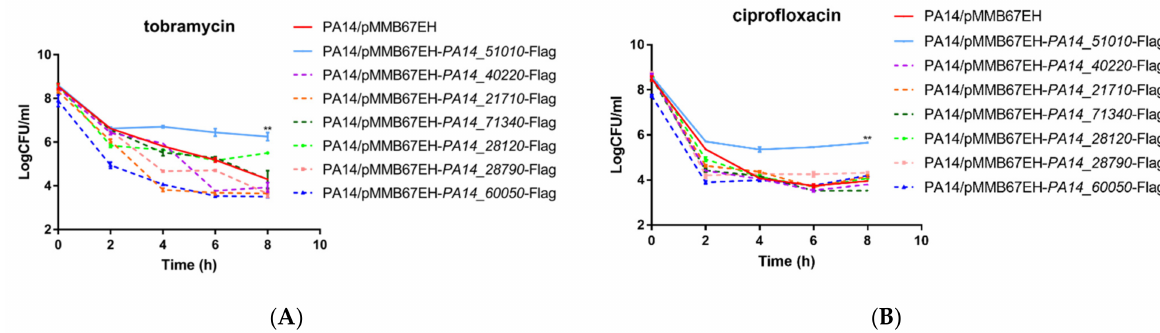
Figure 1. Identification of novel persister formation related genes. Wild-type PA14 overexpressing the indicated genes were treated with 5 µ g/mL tobramycin ( A ) or 0.5 µ g/mL ciprofloxacin ( B ). At indicated time points the live bacteria numbers were determined by serial dilution and plating. Data represent the results from three independent experiments. **, p < 0.01 compared to the other samples by Student’s t